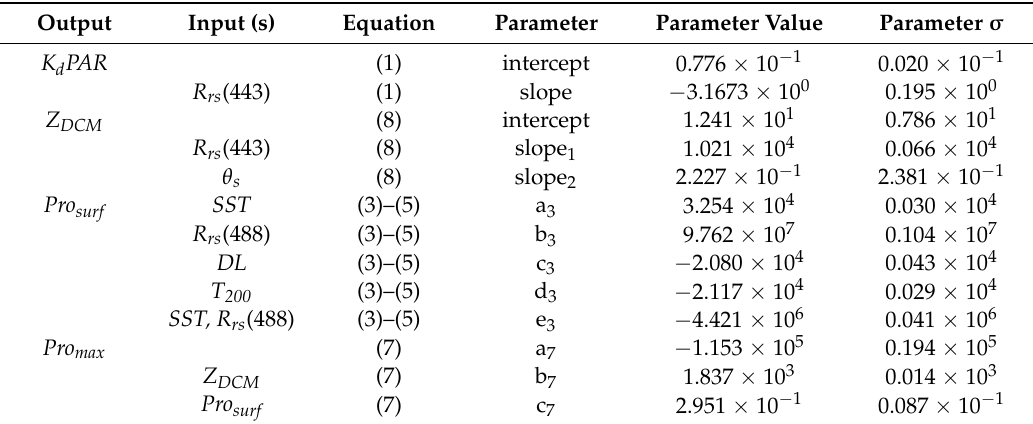
Table 2. The DCM depth, Z DCM , was determined using Equation